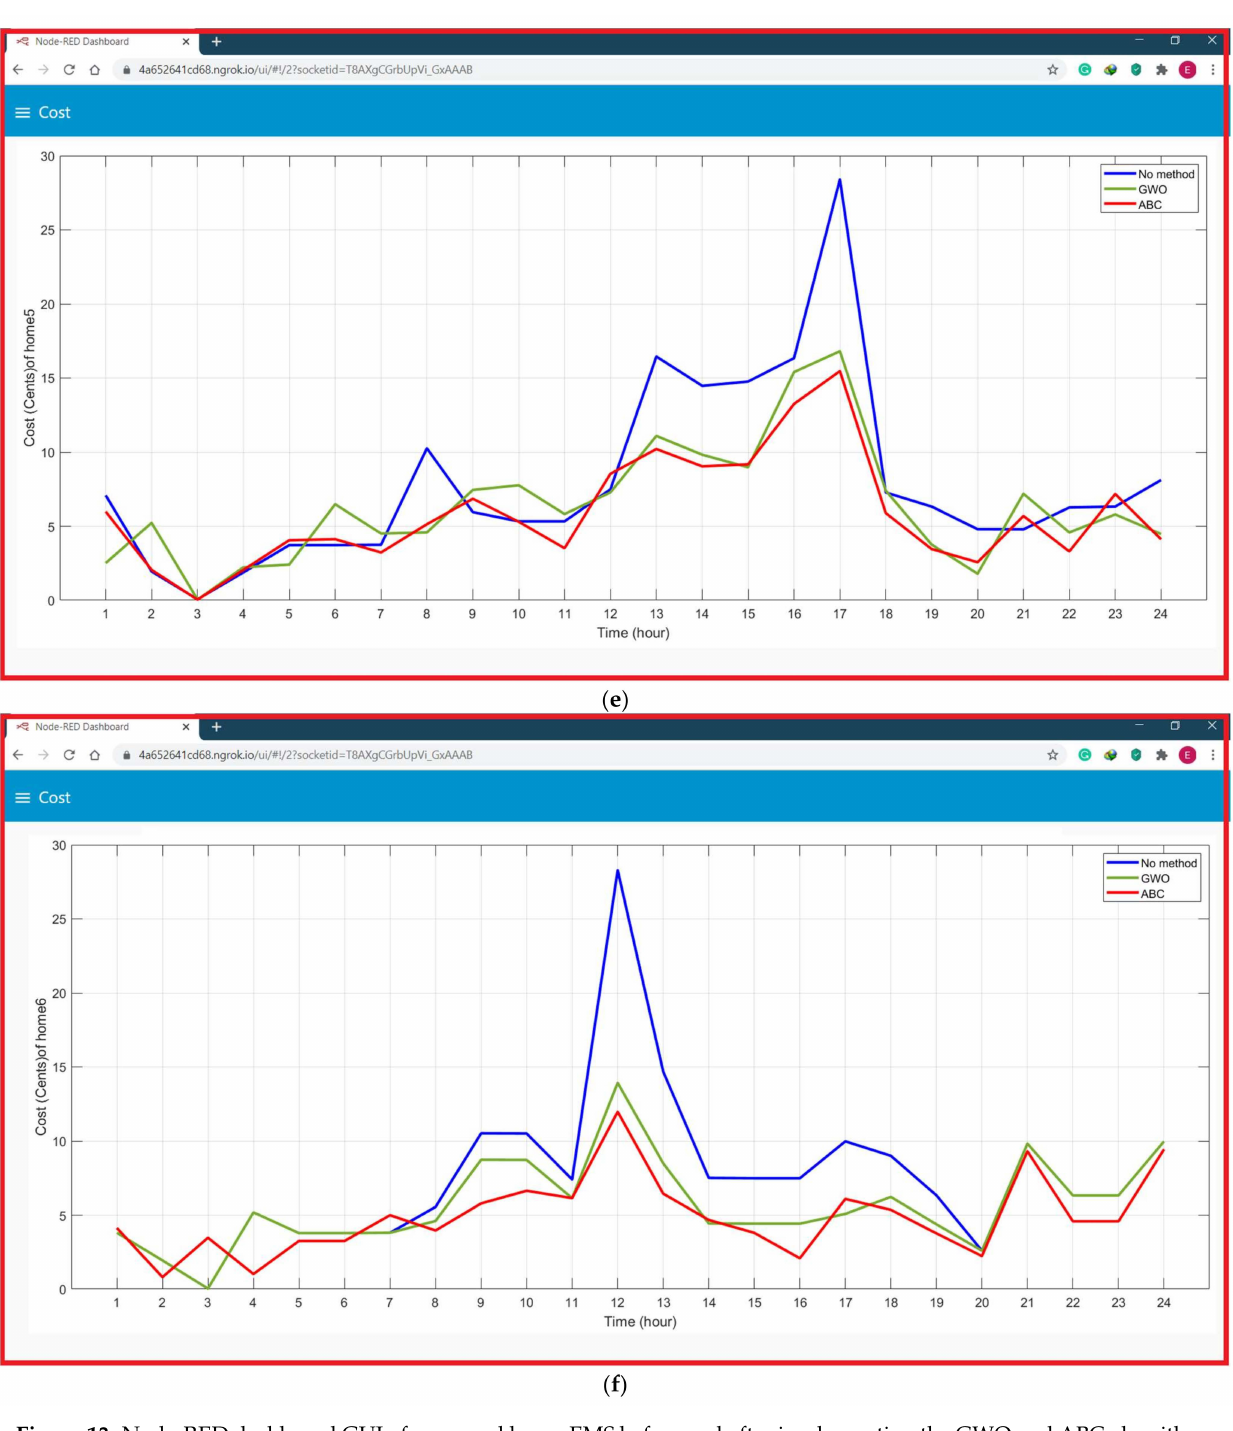
Figure 13. Node-RED dashboard GUI of proposed home EMS before and after implementing the GWO and ABC algorithms, ( a ) cost profiles of first house, ( b ) cost profiles of second house, ( c ) cost profiles of third house, ( d ) cost profiles of fourth house, ( e ) cost profiles of fifth house and ( f ) cost profiles of the sixth